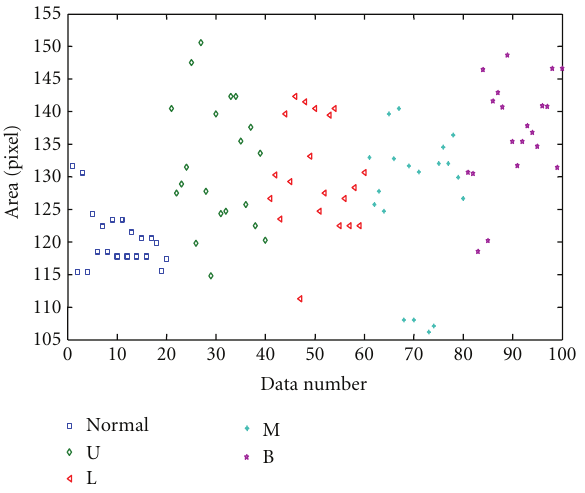
Figure 13: Feature central moment η 01 of thermal image.